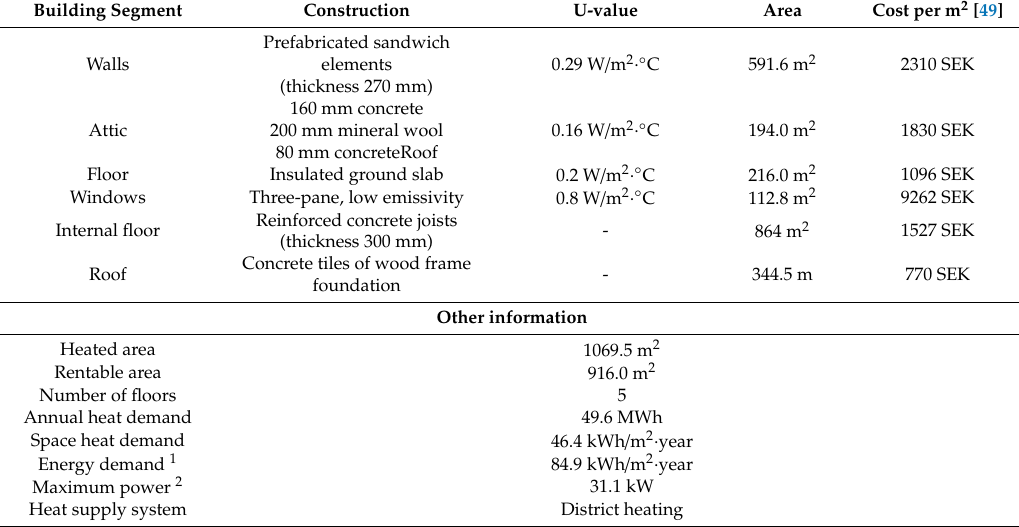
Table 11. Construction, U-values, and energy performance of the new building designed in accordance with the Swedish building code.